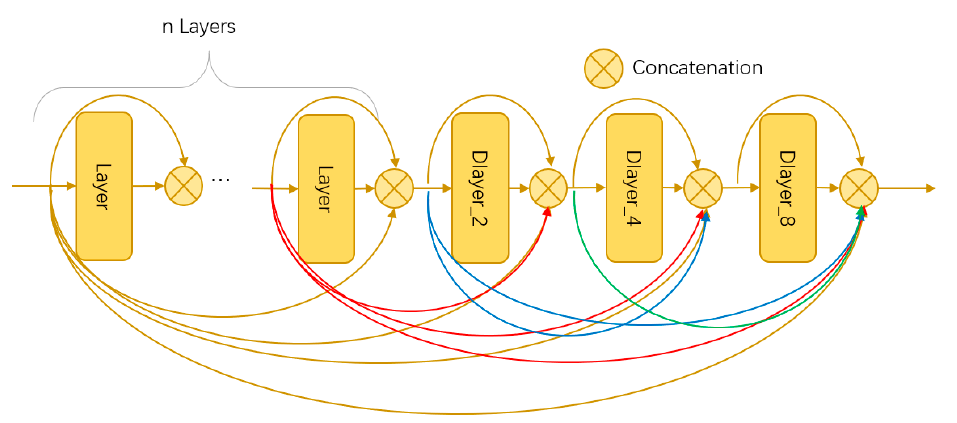
Figure 3. The construction of the D-Dense block.